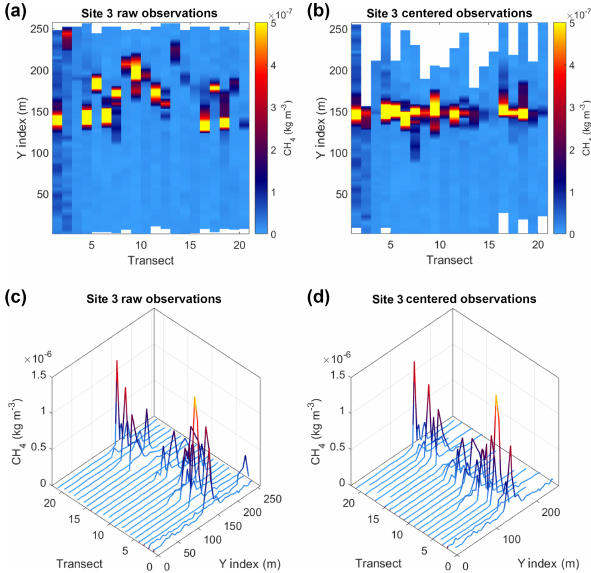
Figure 7. (a) Site 3 raw observations as indexed to the LES do- main and (b) after they have been aligned with the peak of the LES plume. Waterfall plots of the same data for (c) raw observations and (d) centered